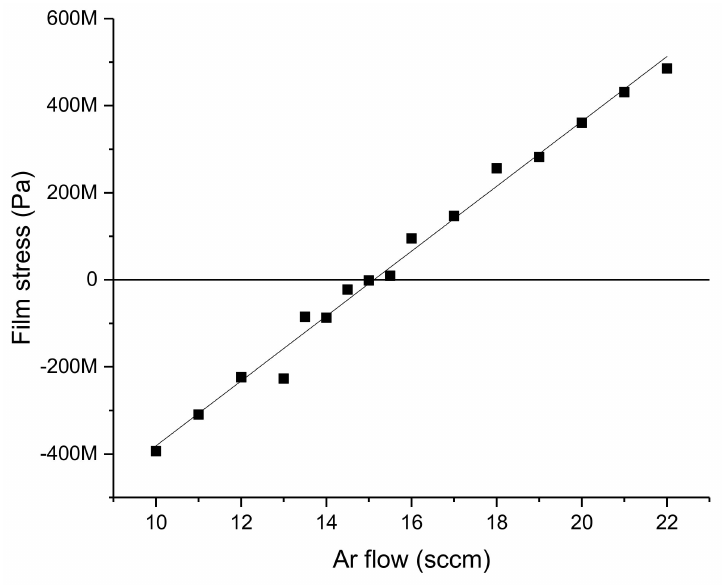
Figure 5. Intrinsic stress of the sputtered FeCuNbSiB against the Ar flow rate during sputtering. The fabrication process was similar to the process described in [27]. The structuring of the metal alloy was performed by ion-beam milling using OFPR-800 200cp (Tokyo Ohka Kogyo). For the wire bonding contacts, electrodes were deposited by RF magnetron sputtering as a 400 nm Au layer and a 20 nm Cr adhesion layer. After photolithography, patterning by wet etching using aqueous iodine solution (KI + I2) was performed to form the wire bonding pads. To form a mask for the Si reactive ion etching (RIE), the SiO 2 layer on the backside was etched by buffered HF. Through RIE (MUC-21, SPT), the cantilever was formed with a thickness of 100 µ m.